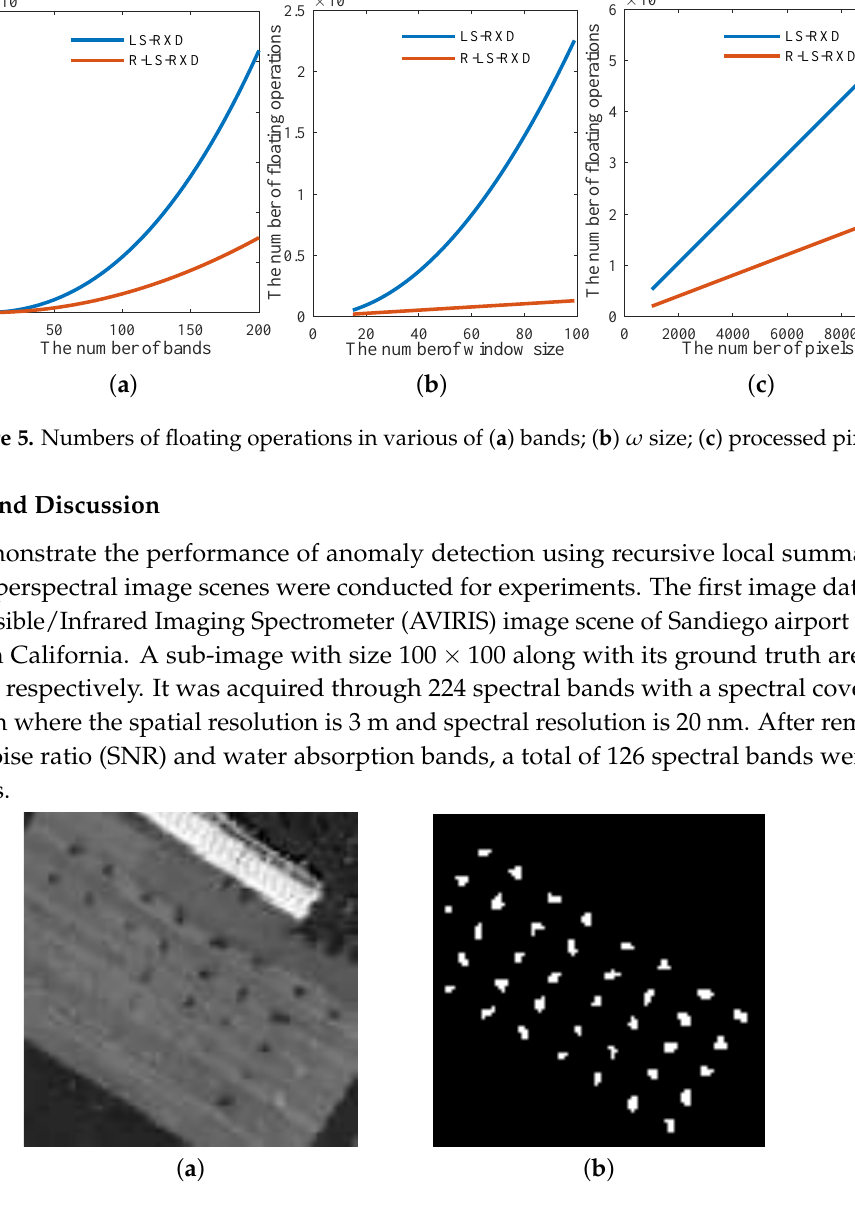
Figure 6. Sandiego hyperspectral image ( a ) 30th band scene; ( b ) ground